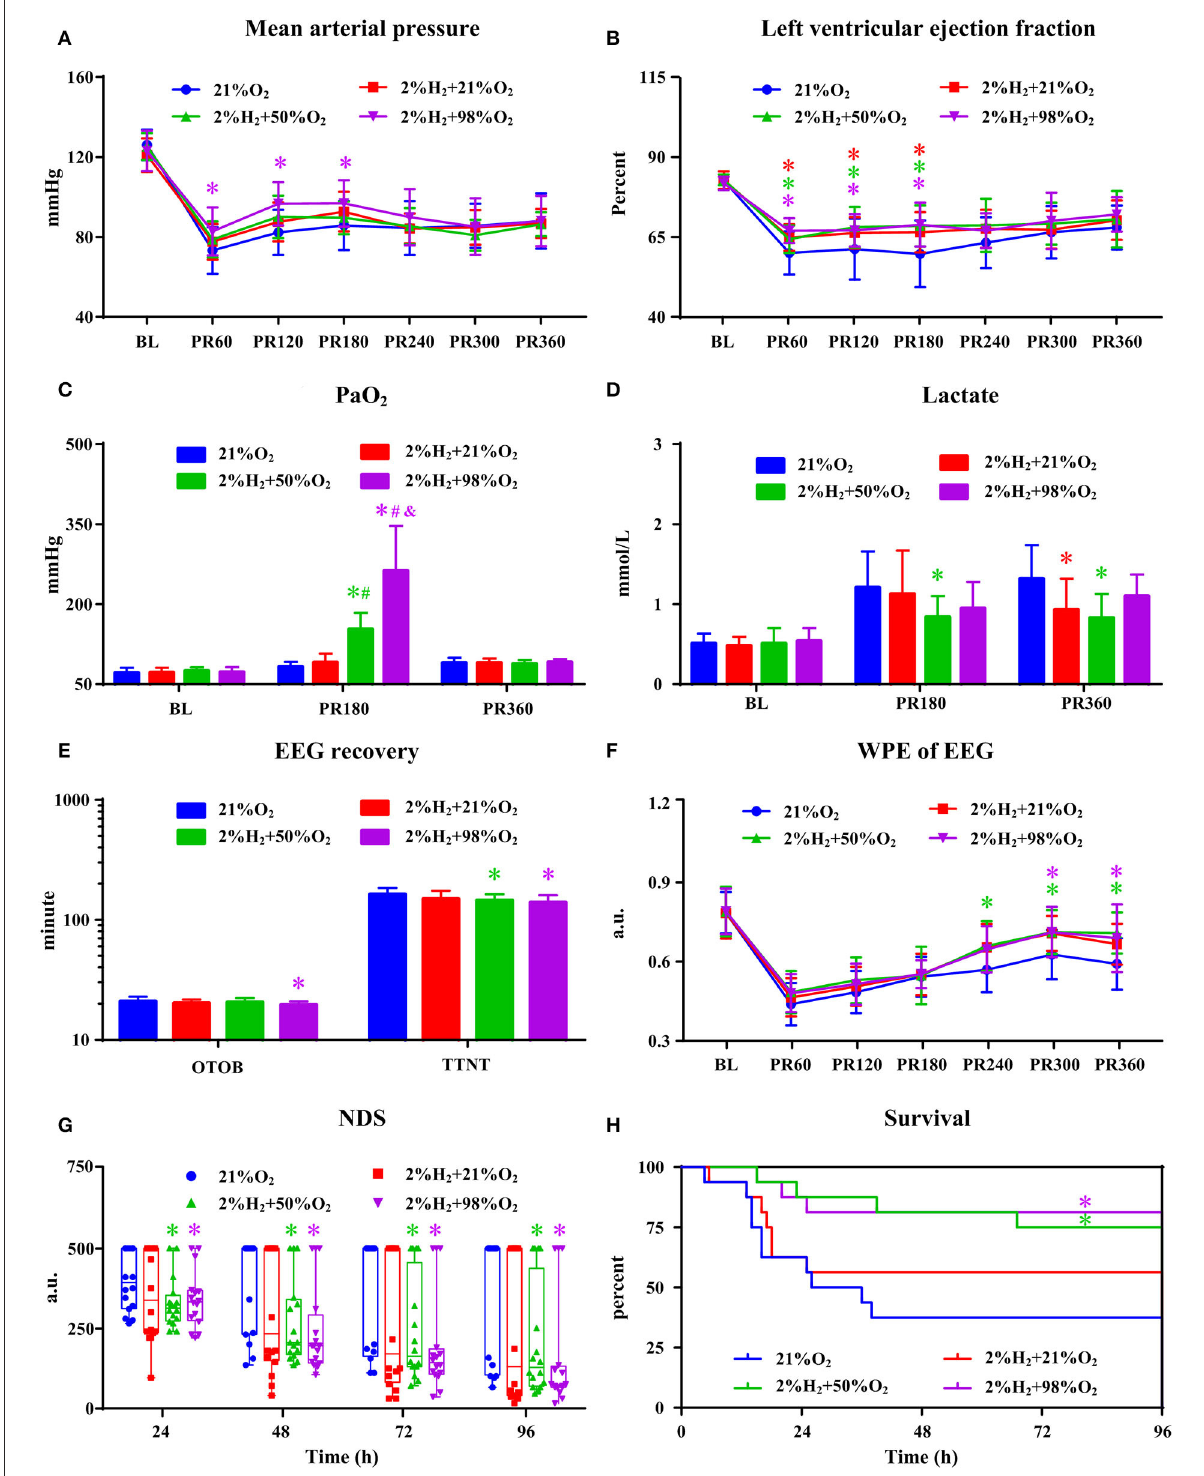
FIGURE1 The hemodynamic and neurological data in animals under normothermia. (A) Mean arterial pressure (MAP), (B) left ventricular ejection fraction (LVEF), (C) PaO 2 , (D) lactate, (E) EEG recovery, (F) weighted-permutation entropy (WPE) of EEG, (G) neurological deficit score (NDS), and (H) survival curve. BL, baseline; PR, post-resuscitation. * p < 0.05 vs. 21%O 2 group; # p < 0.05 vs. 2%H 2 + 21%O 2 group; & p < 0.05 vs. 2%H 2 + 50%O 2